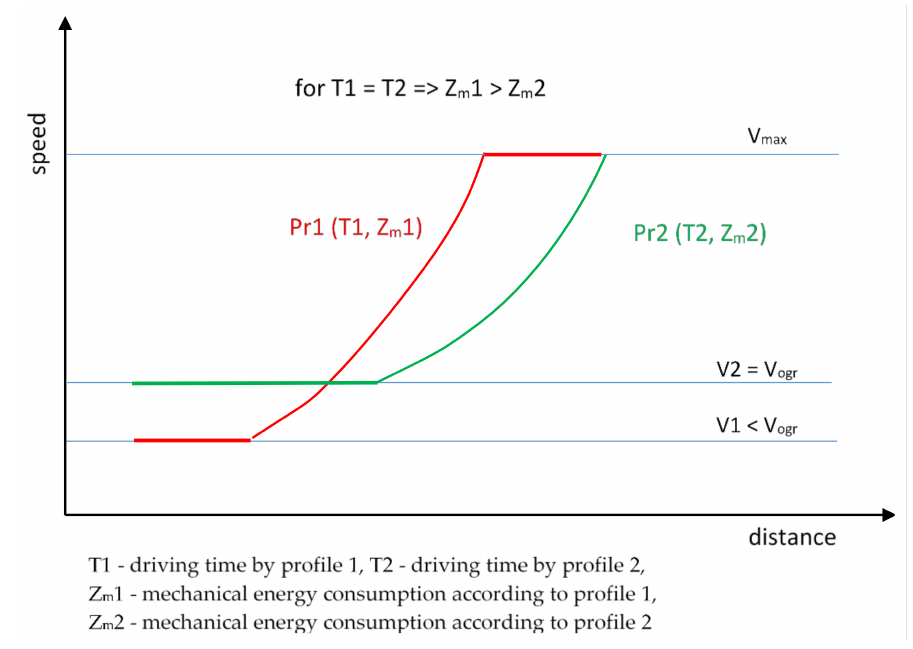
Figure 2. Consequence of loss of speed by the train (source: own